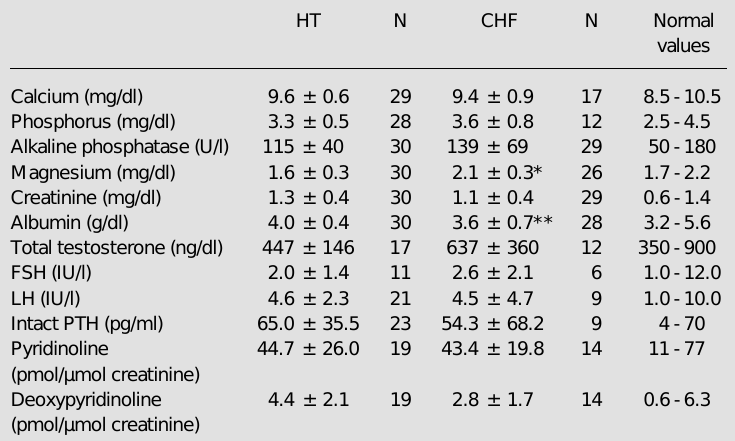
Table 2 - Biochemical parameters and hormonal determinations for heart transplant (HT) and chronic heart failure (CHF) patients.